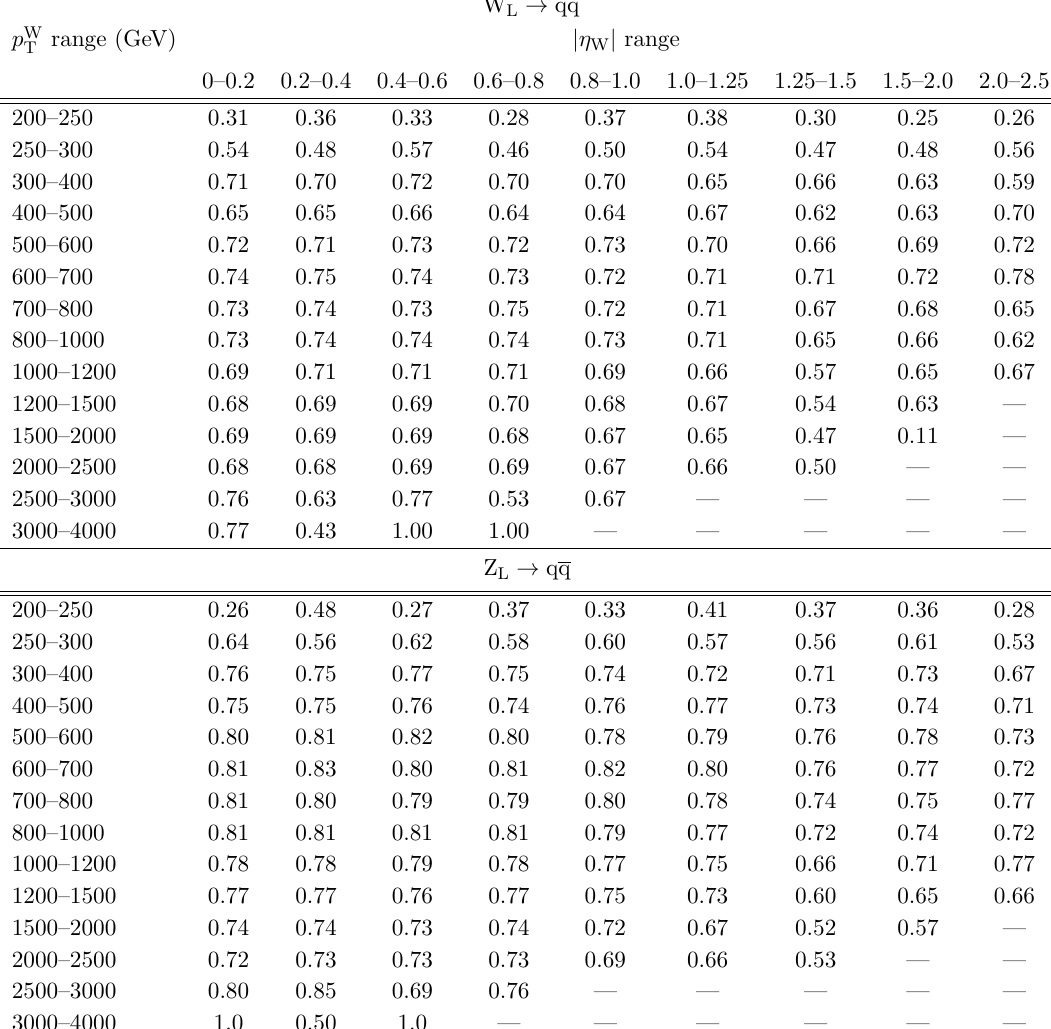
Table 12 . Reconstruction and identi(cid:12)cation e(cid:14)ciency for the (upper table) W L ! qq and (lower table) Z L ! qq decay as a function of generated p V and j (cid:17) V j applying the V tagging requirements T used in the ‘(cid:23) +jet analysis ( (cid:28) 21 < 0 : 6). Uncertainties in the e(cid:14)ciencies are included in the generic limit calculation as discussed in the